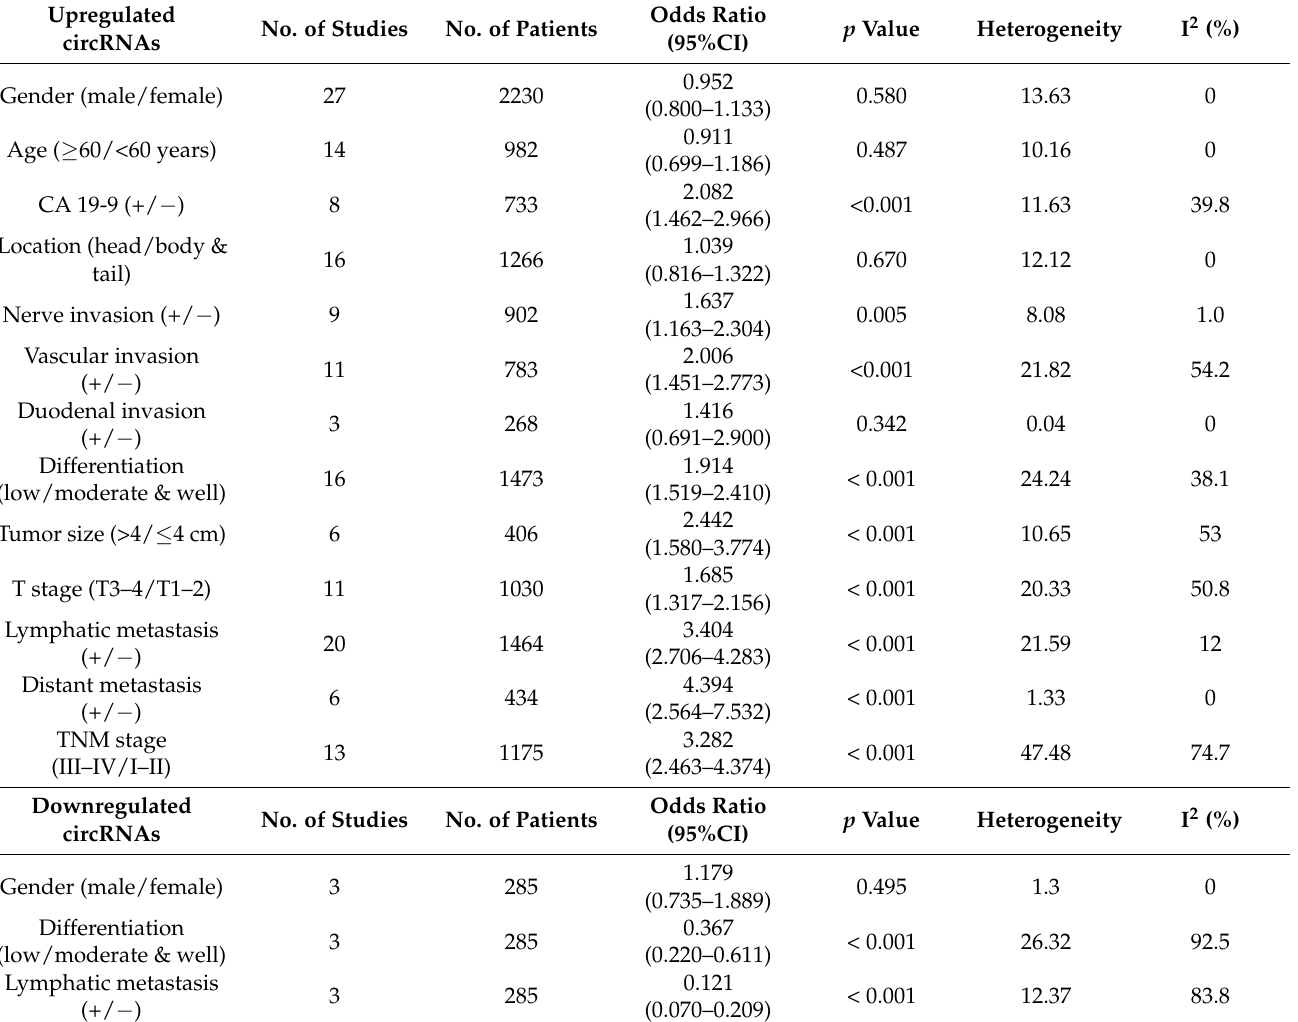
Table 3. Meta-analysis of correlation between upregulated circRNAs and clinicopathological features of pancreatic